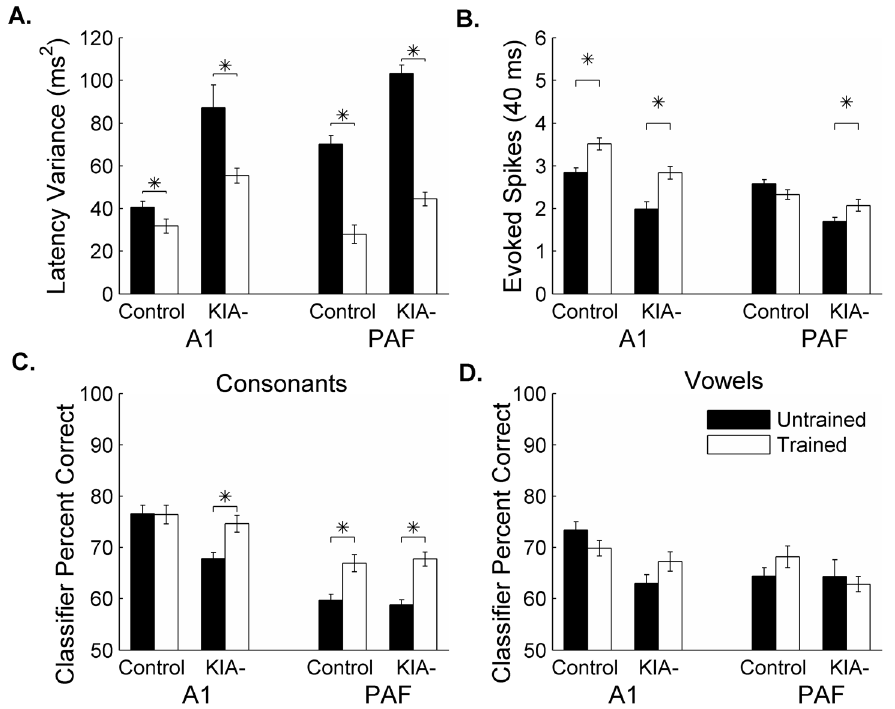
Figure 5. Extensive behavioral training improves reliability of neural firing and neural discrimination performance. A . Training significantly decreased the variability in onset latency in KIA- A1 (*=p , 0.01) and KIA- PAF (*=p , 0.01). Training also decreased variability in control A1 (*=p=0.04) and control PAF (*=p , 0.01). B . Training significantly increased the number of evoked spikes (*=p , 0.04). C . Consonant classifier performance before and after training. (*=p , 0.01). D . Vowel classifier performance before and after